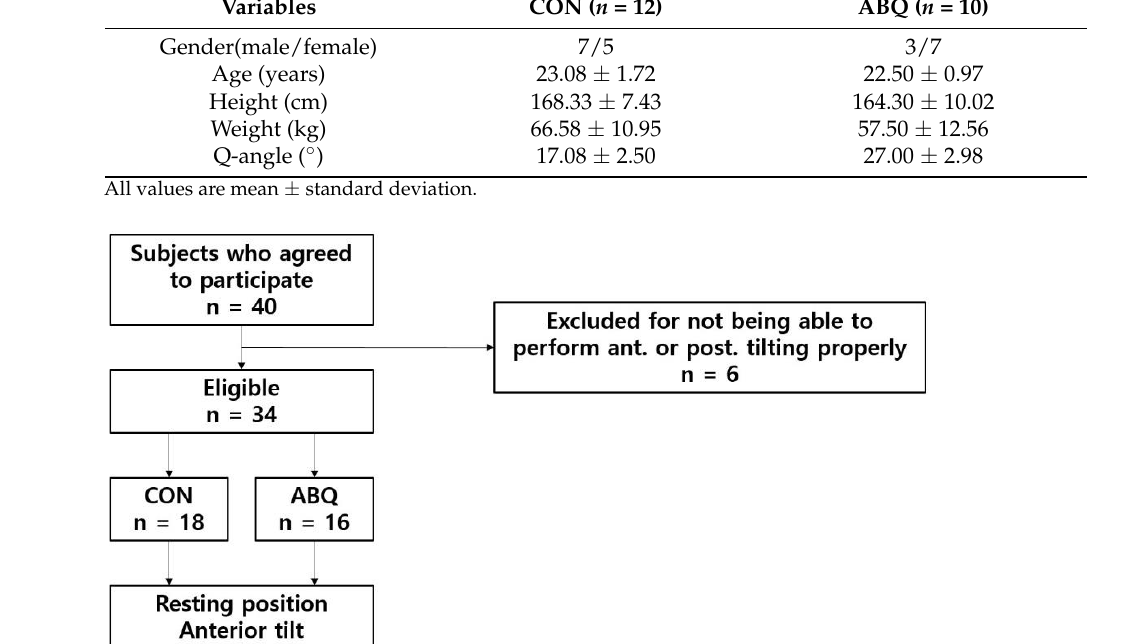
Table 1. General characteristics of the participants. Variables